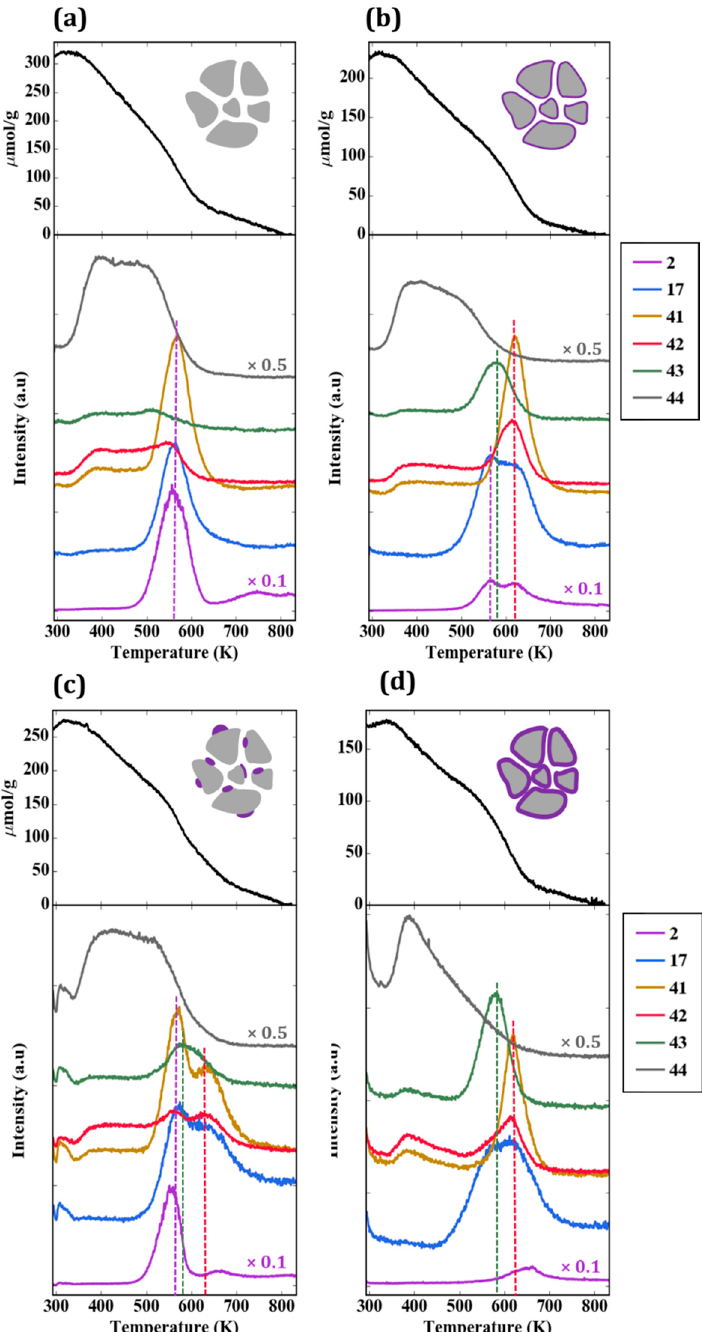
Figure 6. TPD-TGA of 2-propanamine over ( a ) ZrO 2 , ( b ) 5W-Zr, ( c ) impW-Zr, and ( d ) 20W-Zr. The desorption features correspond to hydrogen ( m / e = 2), ammonia ( m / e = 17), a mixture of butenes and acetonitrile ( m / e = 41), acetone ( m / e = 43), propene ( m / e = 41 and 42), and unreacted 2-propanamine ( m / e = 44).